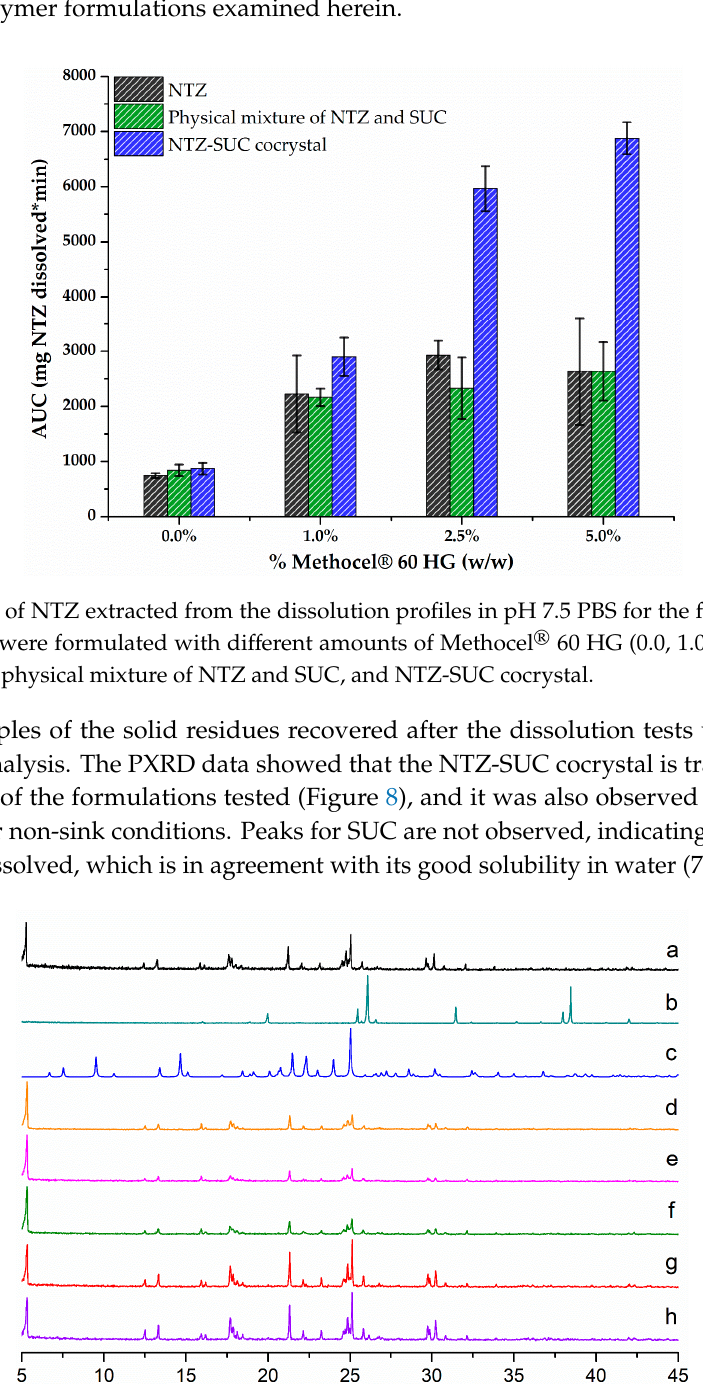
Figure 8. PXRD patterns of (a) NTZ, (b) SUC, (c) NTZ-SUC cocrystal (simulated from SCXRD data) and solid residues after dissolution tests in USP 1 apparatus: (d) NTZ-SUC formulated with 1.0% w / w Methocel ® 60 HG, (e) NTZ-SUC formulated with 2.5% w / w Methocel ® 60 HG, (f) NTZ-SUC formulated with 5.0% w / w Methocel ® 60 HG, (g) NTZ formulated with 5.0% w / w Methocel ® 60 HG, and (h) physical mixture of NTZ and SUC formulated with 5.0% w / w Methocel ® 60 HG.